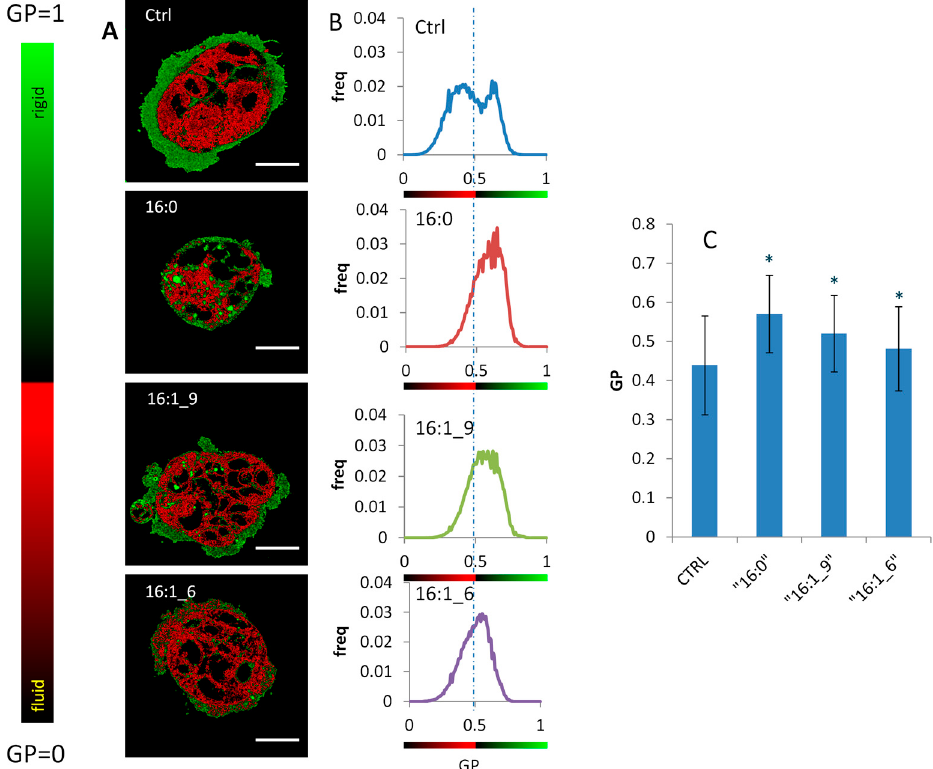
Figure 5. Membrane fluidity of Caco-2 cells resulting from different fatty acid supplementations. ( A ) Ratiometric Laurdan fluidity maps (scale bar 20 µ m) of representative Caco-2 cells reported after 4 h for untreated cells (Ctrl), palmitic acid (16:0), palmitoleic acid (9 cis -16:1) and sapienic acid (6 cis -C16:1) 150 µ M treatments in a two-coloured pseudoscale, spanning from red (very fluid) to green (very rigid). ( B ) GP histograms of the fluidity images for (from top to bottom): Untreated cells (Ctrl), palmitic acid (16:0), palmitoleic acid (9 cis -C16:1) and sapienic acid (6 cis -C16:1). The range of the histograms goes from 0 (very fluid regions) to 1 (very rigid regions). ( C ) Mean Values of GP histograms for the different treatments (* p < 0.05 compared to Ctrl).